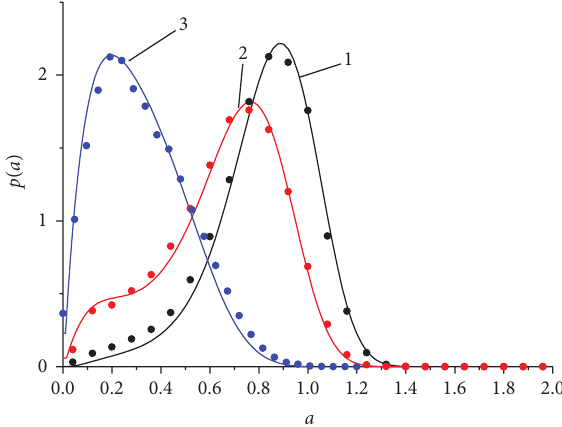
Figure 6: Stationary probability density 𝑝(𝑎) for different values of the fast excitation parameter 𝐸 22 ⋅ 𝑟 𝑓 . Line 1: no fast excitation; line 2: 𝐸 22 ⋅ 𝑟 𝑓 = 0.4; line 3: 𝐸 22 ⋅ 𝑟 𝑓 = 0.8. Dotted lines are from direct numerical simulations of the nonlinear model (5).